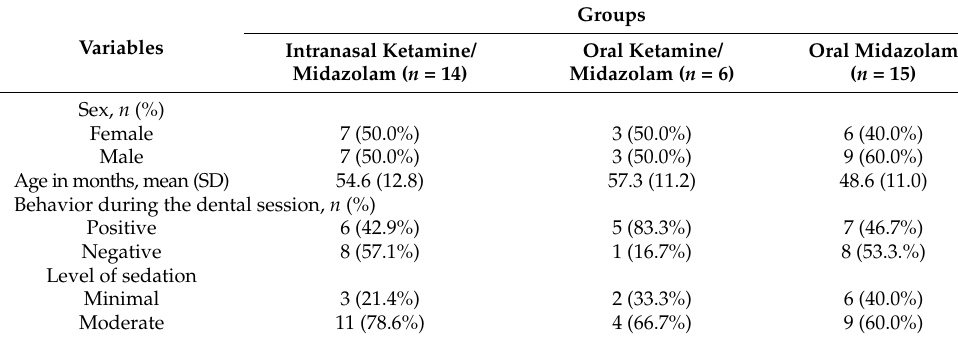
Table 2. Characteristics of children according to sedative